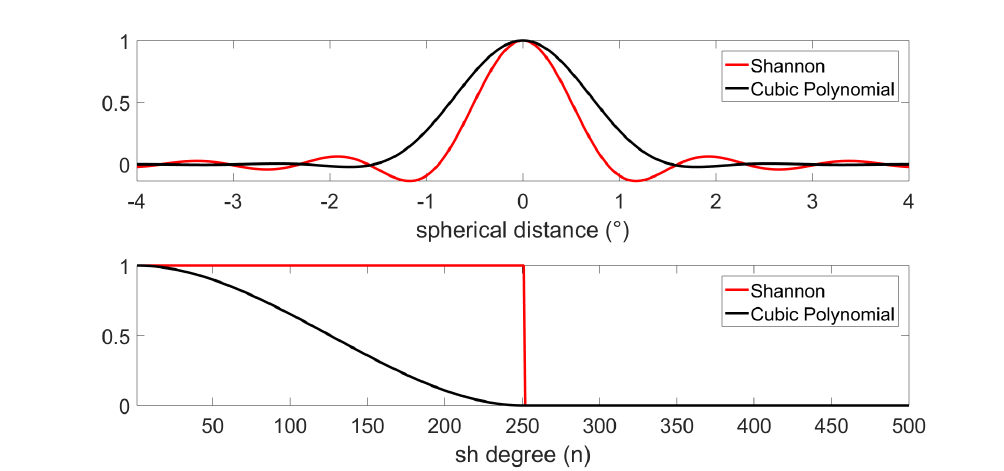
Figure 1. The different spherical radial basis functions (SRBFs) in the spatial domain ( top , ordinate values are normalized to 1) and the spectral domain ( bottom ) for N max =